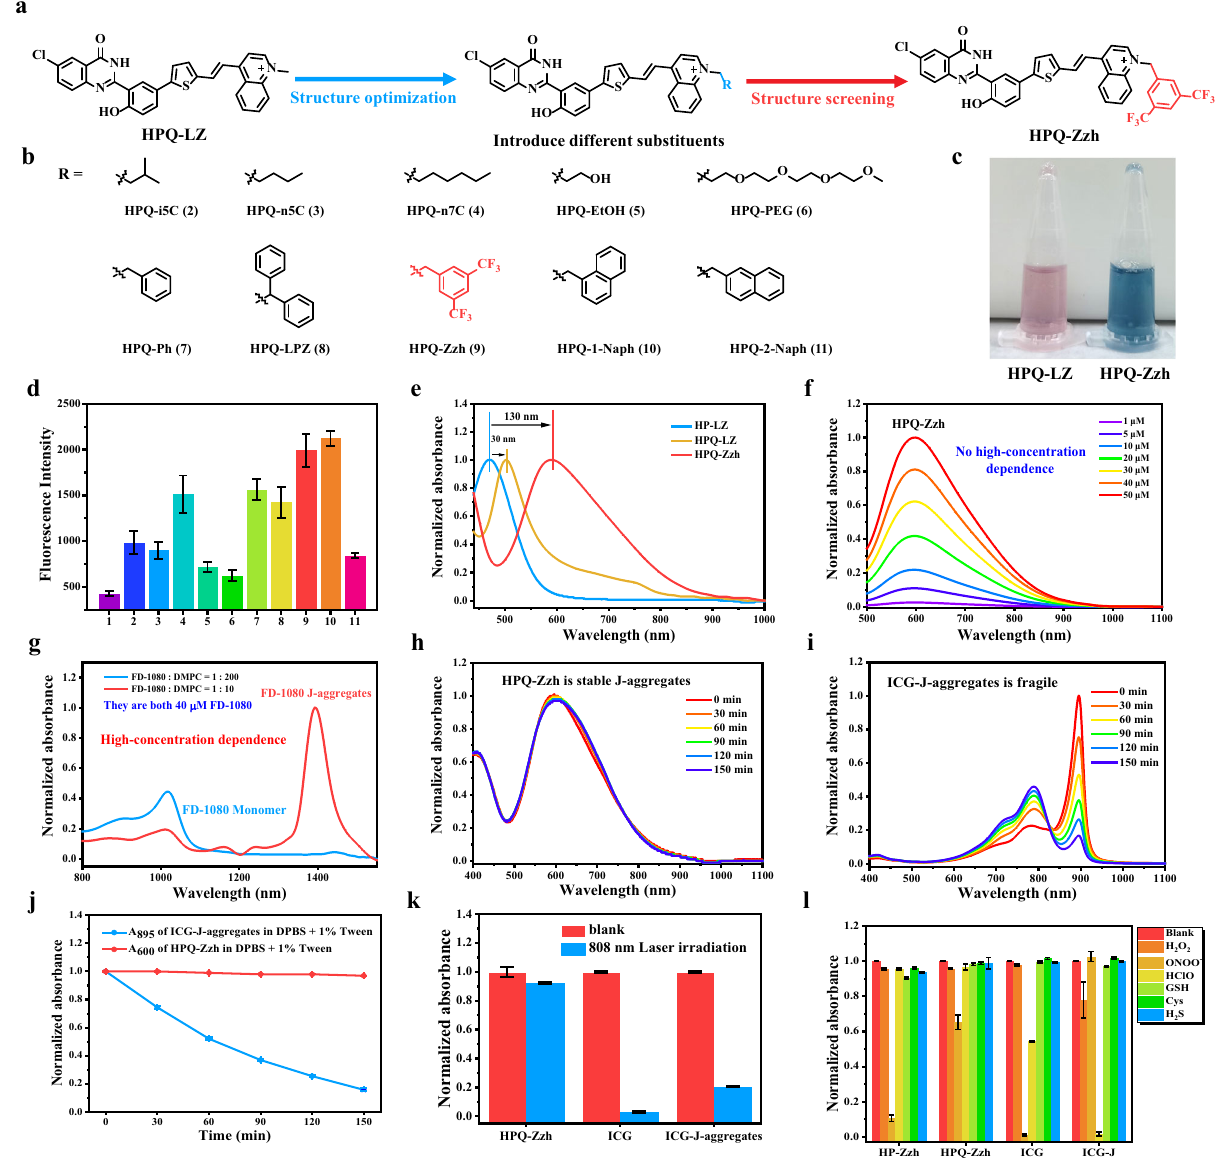
Fig. 4 | Improved strategy of NIR-II-J-aggregates for the water environment. a Modi fi cationmethod. b Compoundswithdifferentsubstituents. c Photosof HPQ- LZ (left) and HPQ-Zzh (right) in DPBS+1% Tween. d NIR-II fl uorescence of all HPQ (20 μ M) in DPBS+1% Tween, (1) HPQ-LZ , (2) HPQ-i5C , (3) HPQ-n5C , (4) HPQ-n7C , (5) HPQ-EtOH , (6) HPQ-PEG , (7) HPQ-Ph , (8) HPQ-LPZ , (9) HPQ-Zzh , (10) HPQ-1- Naph , and (11) HPQ-2-Naph , respectively, λ ex =808nm, Collection channel: 1000 – 1700nm,Datawerepresentedasmean±s.d.derivedfrom n =3independent biological samples. e Normalized absorbance of HP-LZ, HPQ-LZ, and HPQ-Zzh in DPBS+1% Tween. f Normalized absorbance spectrum of HPQ-Zzh at different concentrations in DPBS+10% FBS. g Normalized absorbance spectrum of J-aggregateswithadifferentmolarratioof FD-1080 toDMPC,theirconcentrations are both 40 μ M FD-1080. h Normalized absorbance of HPQ-Zzh in DPBS+1%